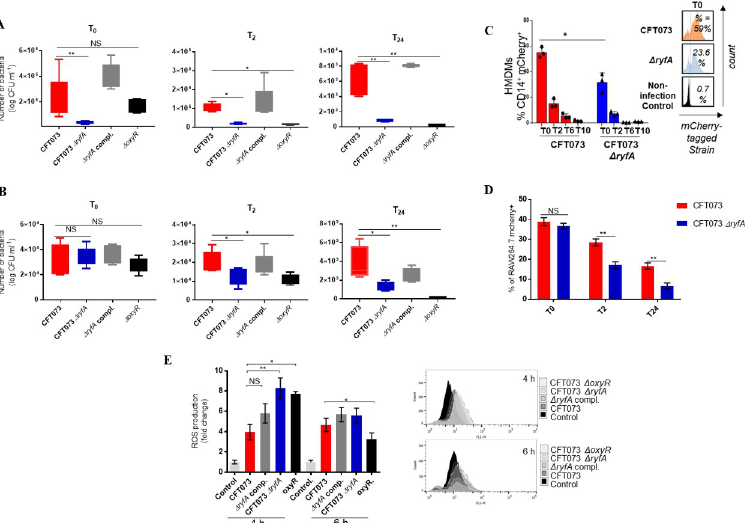
Fig 6. Role of RyfA during interaction with professional phagocytes. Phagocytic cells were infected with CFT073 wild-type strain, Δ ryfA or Δ oxyR isogenic mutants or the Δ ryfA -complemented strain. ( A ) in vitro differentiated human monocyte-derived macrophages (HMDMs) and ( B ) THP-1 human macrophages were infected with different strains for 1 h, followed by gentamicin treatment. Cells were lysed and intracellular bacterial counts (CFU ml − 1 ) were determined at different times post-infection (pi). Infection assessment of mCherry tagged CFT073 strains via flow cytometry in ( C ) HMDMs and ( D ) RAW264.7 cells. ( E ) Reactive oxygen species (ROS) production in RAW264.7 cells. RAW264.7 cells were infected at an MOI of 20 and intracellular generation of ROS was measured at 4 h and 6 h post- infection by using H 2 DCFDA. Cells were stained with 10 μ M H 2 DCFDA. All assays were conducted in triplicate and repeated independently at least three times. The results are expressed as the means ± sem. Significant differences between mutant, WT and complemented mutant strains were determined using One-way ANOVA. � , P < 0.05; �� , P < 0.005; ��� , P < 0.0001. NS, not